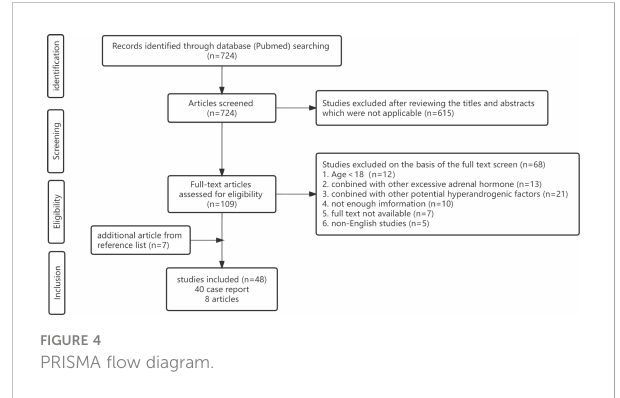
FIGURE 4 PRISMA fl ow diagram.